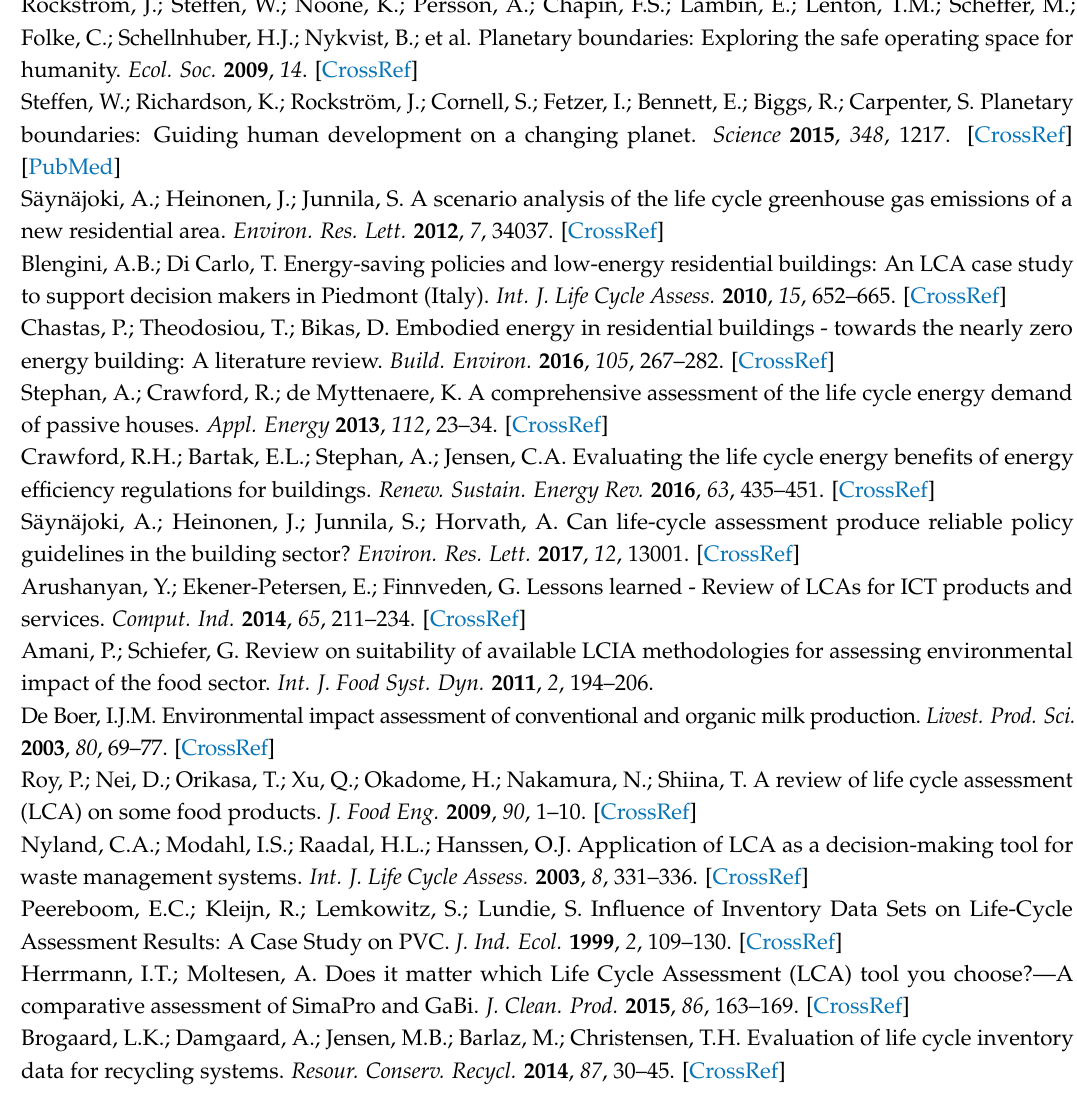
Table S1: KÄPYLÄ 149A GaBi and SimaPro sector choices, Table S2: Pyry GaBi and SimaPro sector